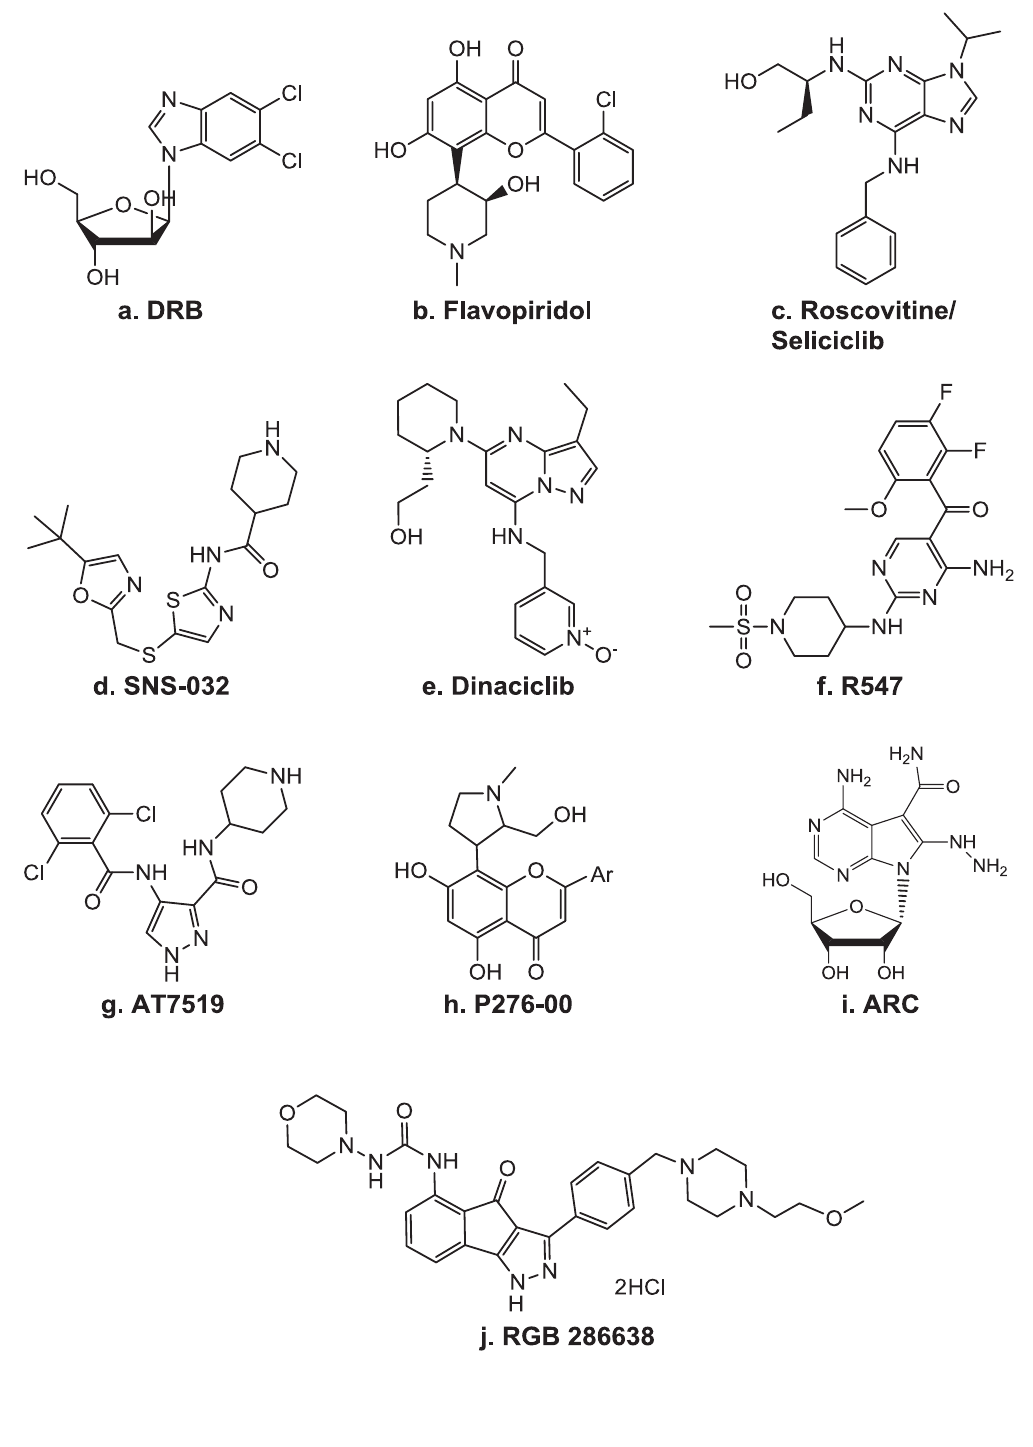
Figure 4. CDK inhibitors. Structures of ( a ) DRB, ( b ) flavopiridol, ( c ) seliciclib ( d ) SNS-032, ( e ) dinaciclib, ( f ) R547, ( g ) AT8319, ( h ) P276-00, ( i ) ARC, and ( j ) RGB